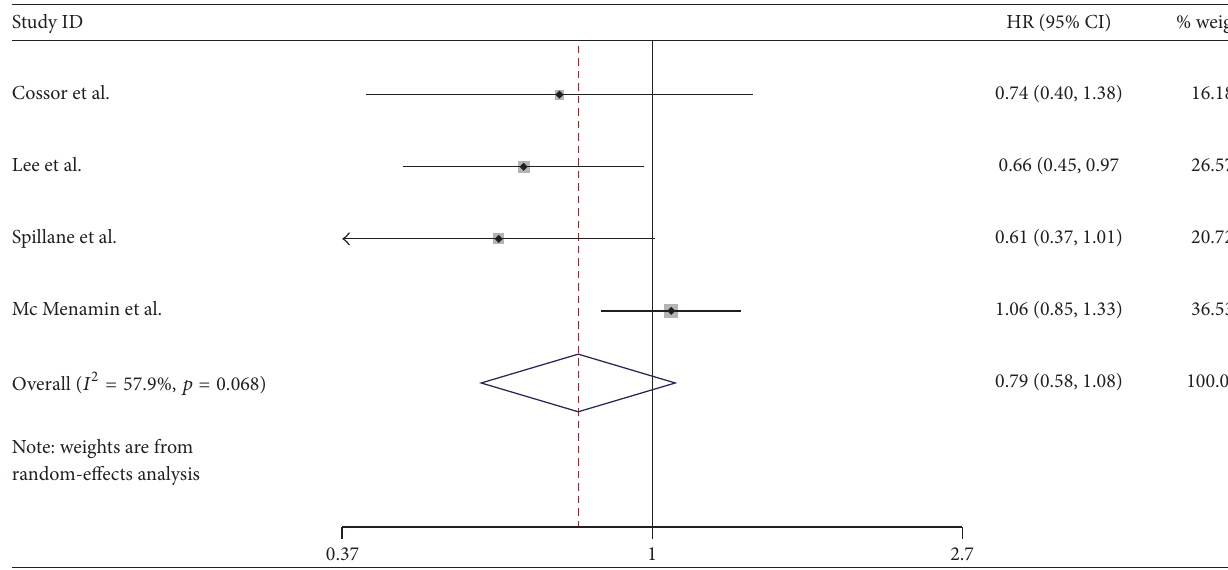
Figure 3: Forest plot of the association between metformin use and cancer-specific